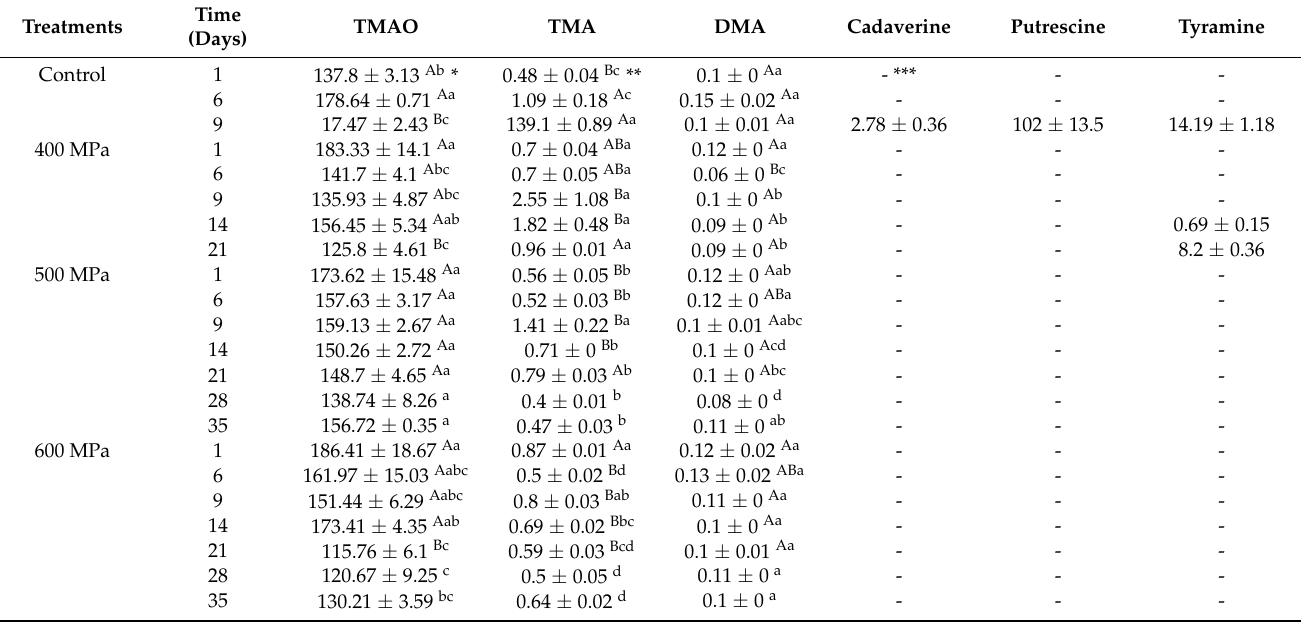
Table 2. Amine concentrations (mg/100 g of flesh) during chilled storage of striped prawn untreated (control) or treated with